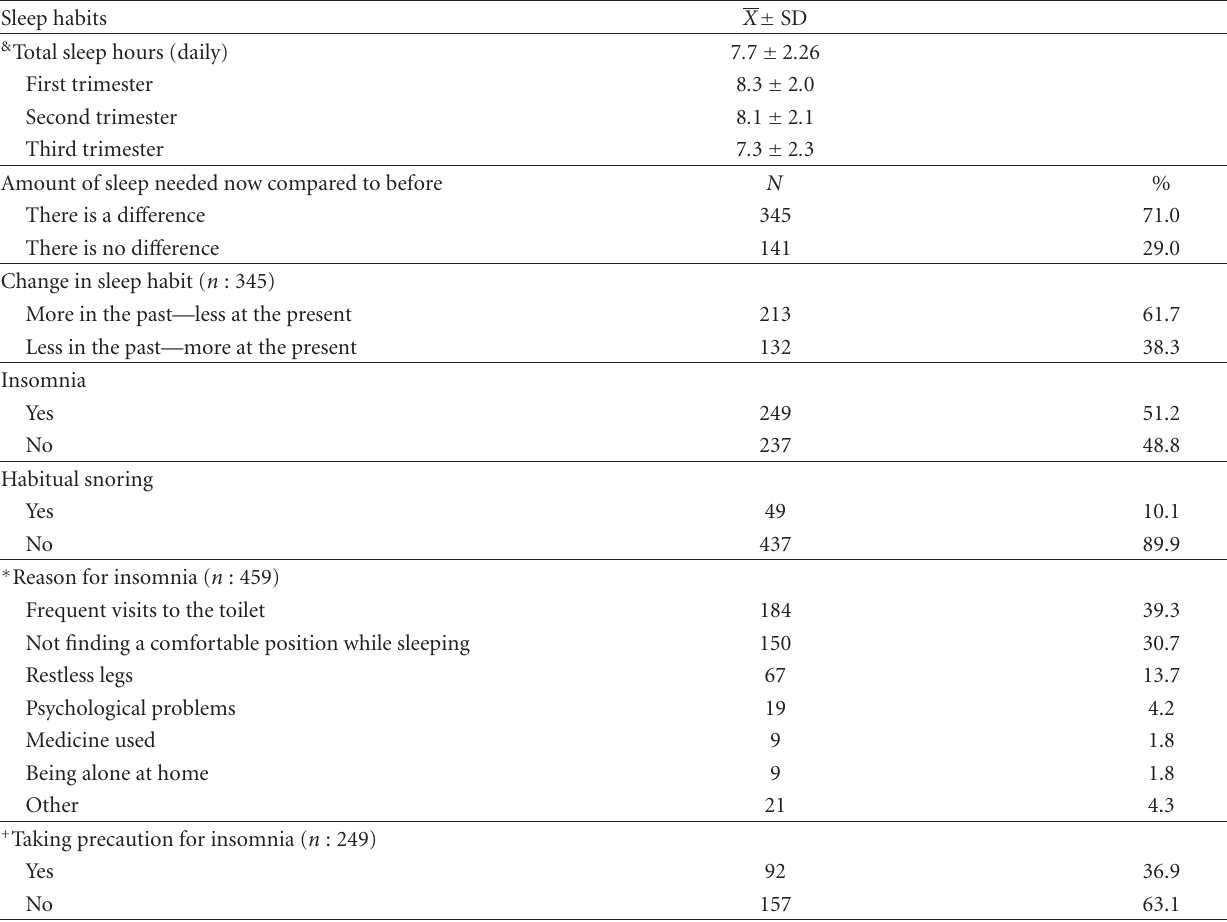
Table 2: Distribution of the pregnant women according to their sleep habits ( N :